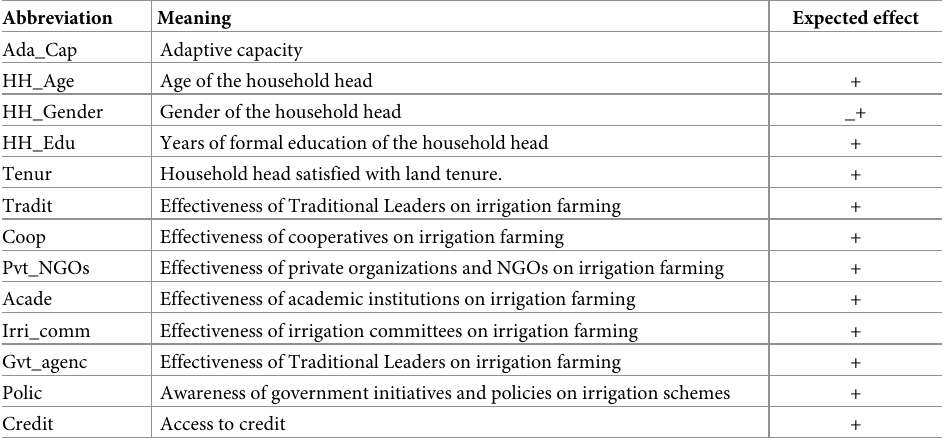
Table 8. Abbreviations and expected effect on adaptive